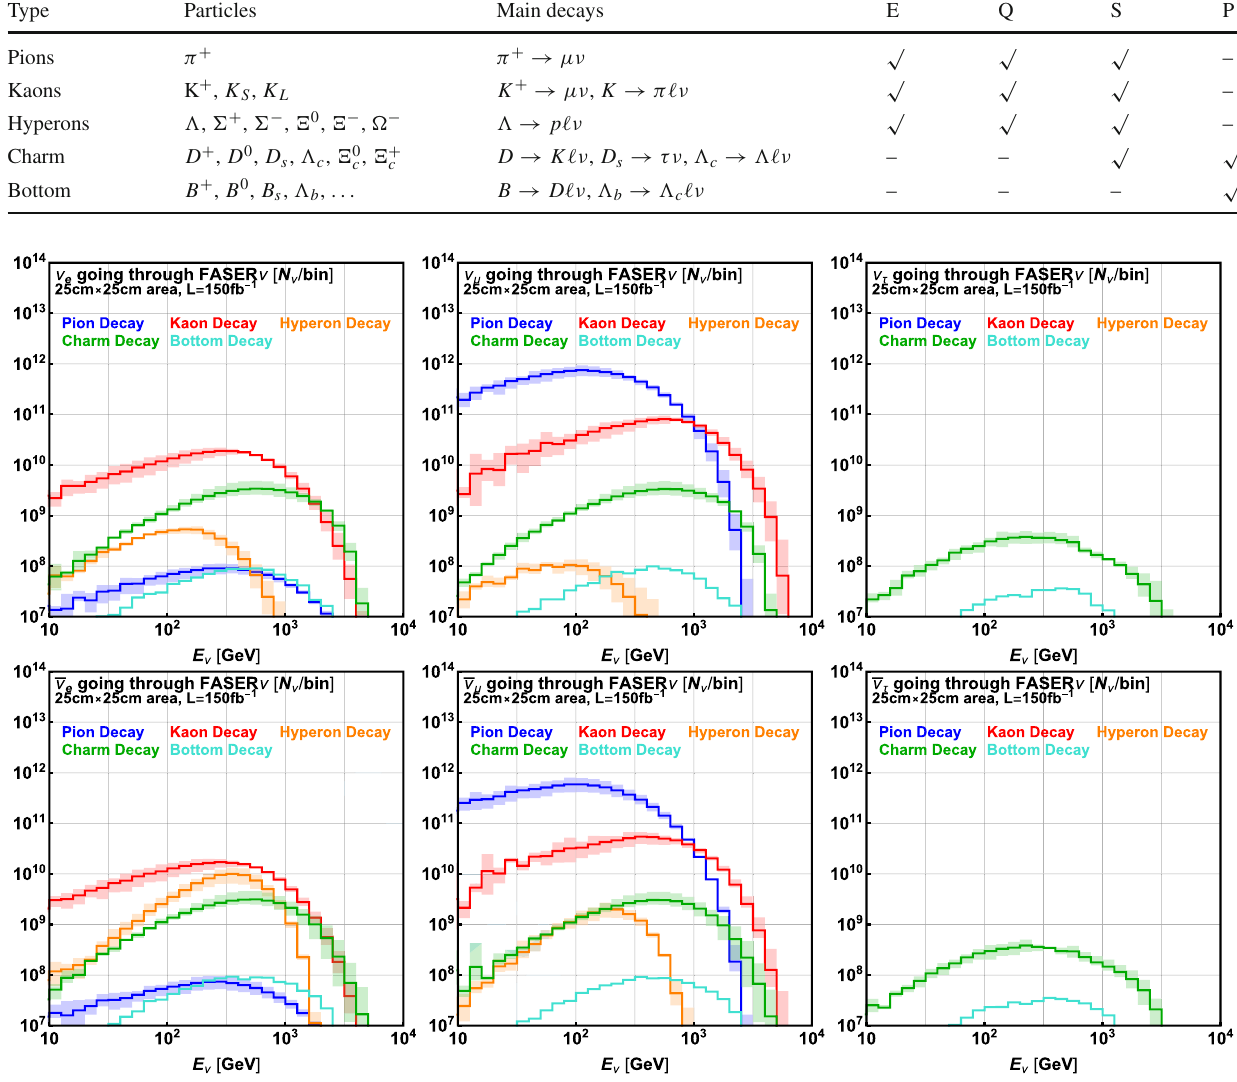
and anti-neutrinos (lower). The shaded bands indicate the range of pre- dictions from the different MC generators listedin Table 1, and the solid contours are the average results of these MC